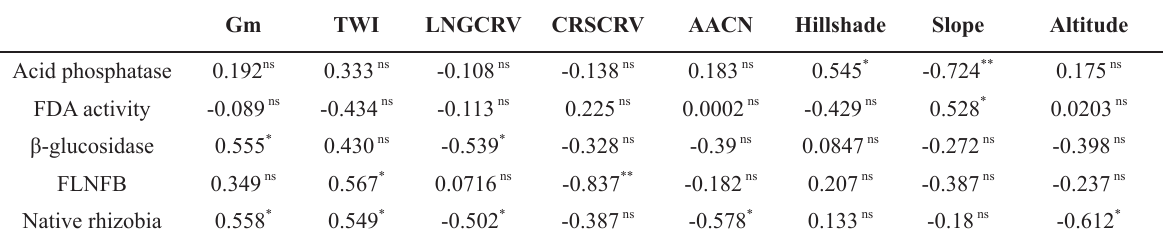
Coefficient of correlation between microbiological attributes and topographic attributes of a hillslope in the Bocaina Mountain Range, in Lavras – Minas Gerais, Brazil.